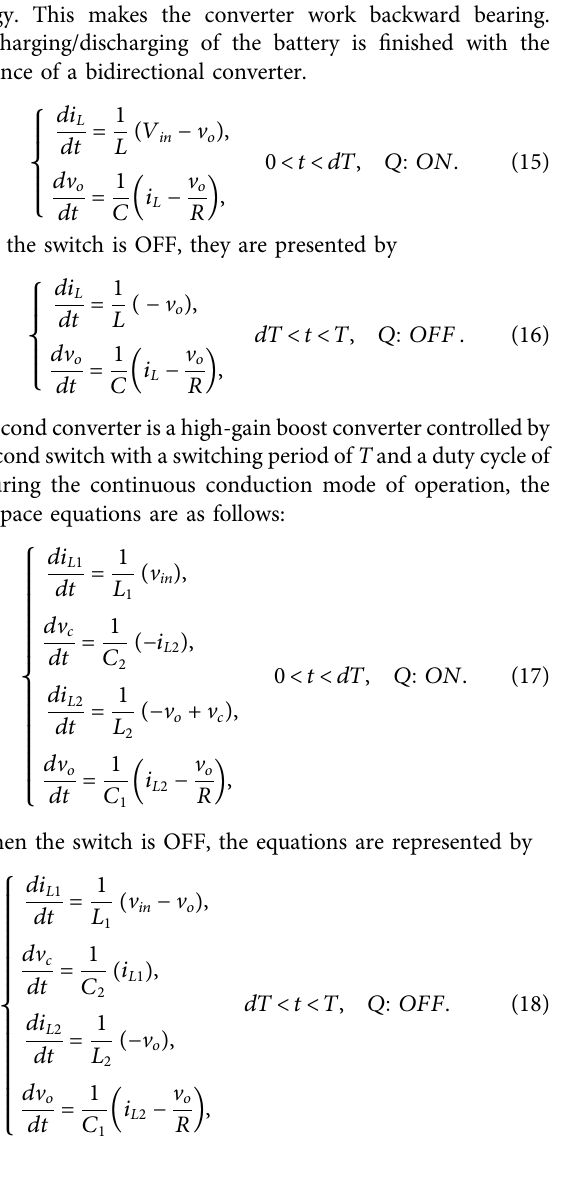
FIGURE 5 | Architecture of the